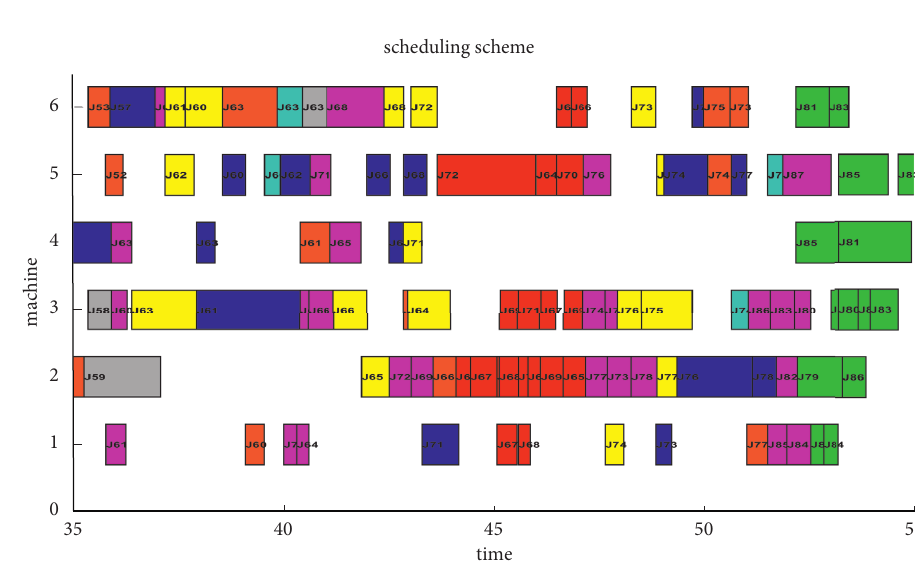
Figure 9: Gantt chart of t � 35–55 scheduling scheme. Table 4: Tasks to be processed at t �